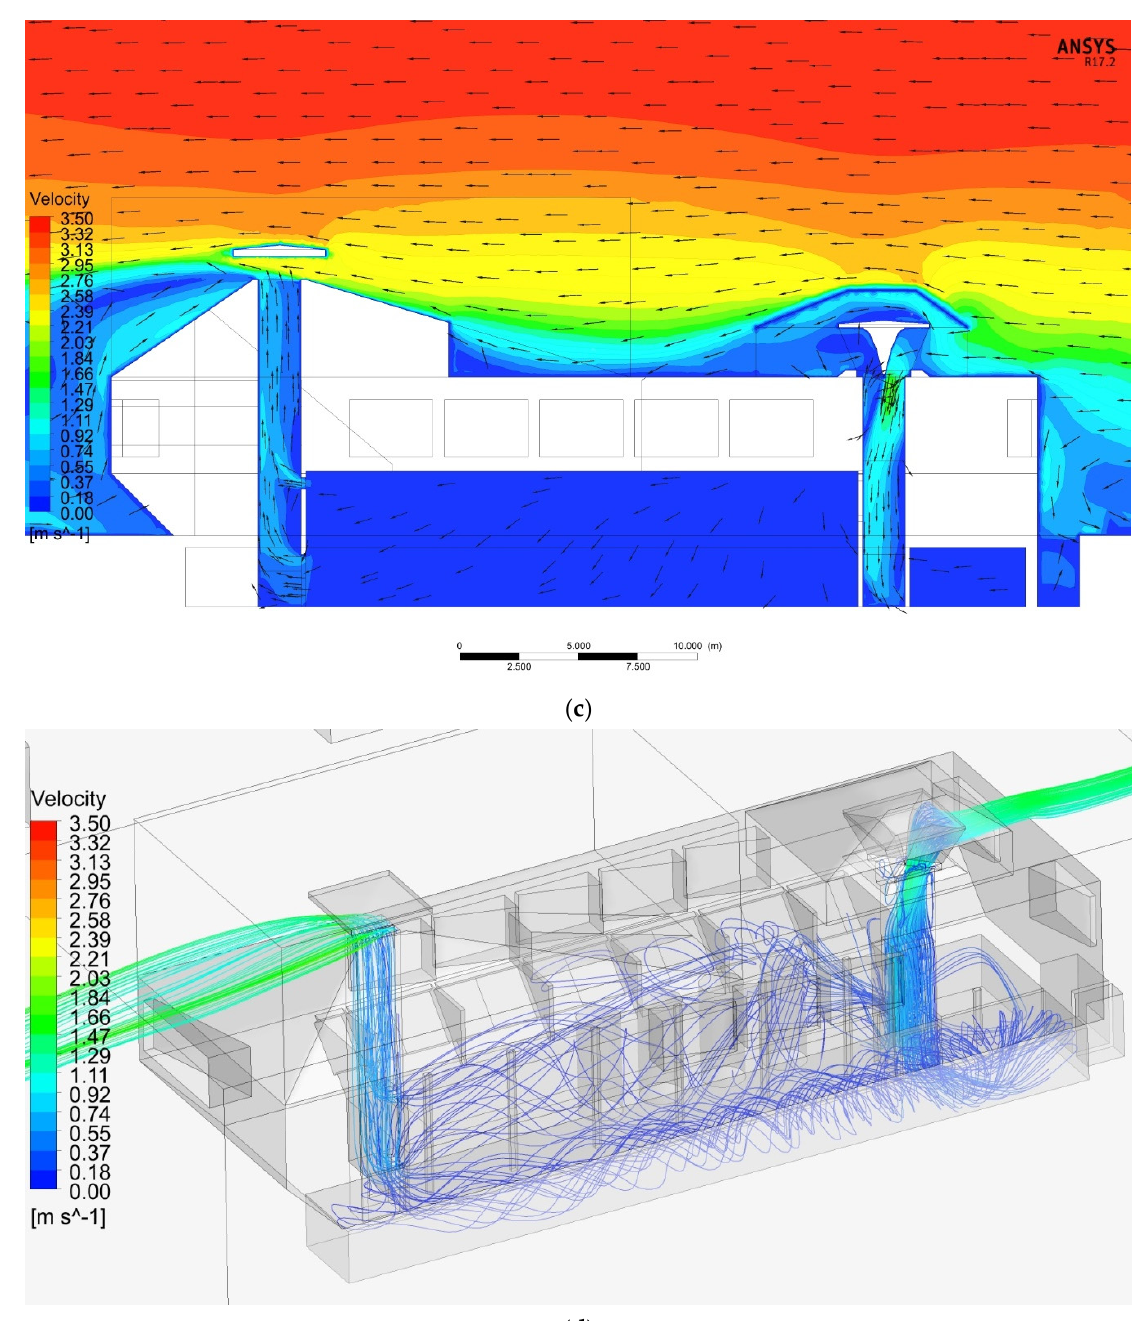
Figure 11. Airflow patterns in the cellar and the industry hall in the case of downdraught (DD) PACS (colors and vectors by air velocity [m/s])—( a ) cross section of the airflow through the outlet tower under NE wind direction, ( b ) cross section through the inlet tower under NE wind direction, ( c ) longitudinal section of the airflow in and around the building under NW wind direction, ( d ) 3D streamlines of the airflow under NW wind direction.